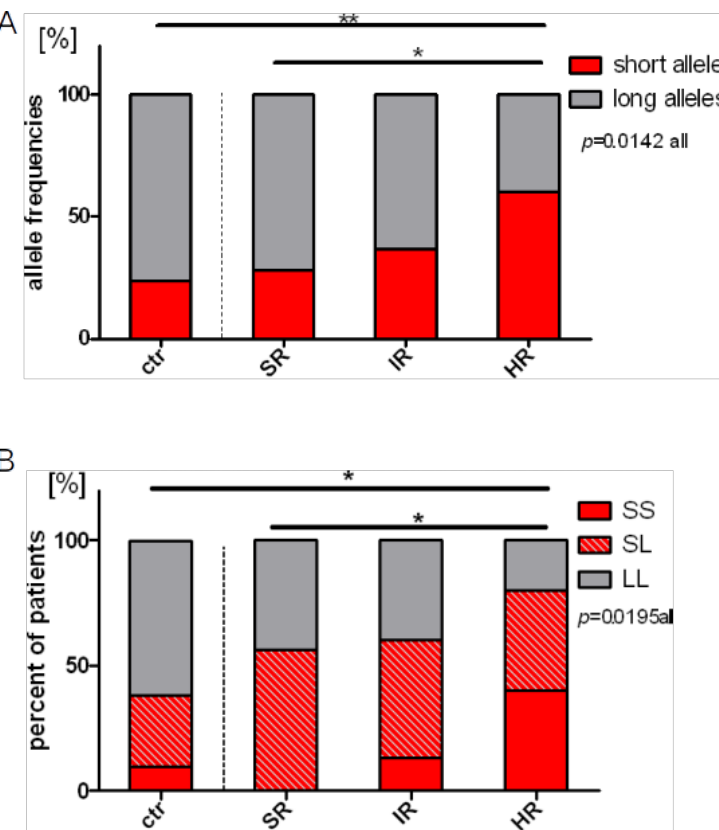
Figure 4. ( A ) Frequencies of short and long alleles in the control group and in patients stratified into the risk groups. In the control group: 20 short alleles (23.8%) and 64 long alleles (76.2%); in the SR group: 9 short alleles (28.1%) and 23 long alleles (71.9%); in the IR group: 22 short alleles (36.7%) and 38 long alleles (63.3%); in the HR group: 12 short alleles (60%) and 8 long alleles (40%); ( B ) Comparison of percentage of individuals with the SS, SL and LL genotypes in the control group and in patients stratified into the particular risk groups. In the control group: SS genotype— 4 individuals (9.5%), SL genotype—12 individuals (28.6%), LL genotype—26 individuals (61.9%). In the SR group: SS genotype—0 patients, SL genotype—9 patients (56.2%), LL genotype—7 patients (43.8%). In the IR group: SS genotype—4 patients (13.3%), SL genotype—14 patients (46.7%), LL genotype—12 patients (40%). In the HR group: SS genotype—4 patients (40%), SL genotype—4 patients (40%), LL genotype—2 patients (20%). *— p < 0.05; **— p < 0.01.